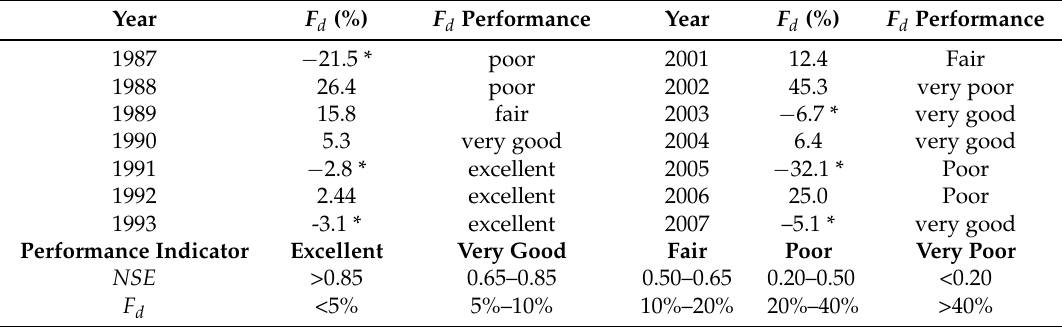
Table 3. Differences between simulated and observed annual discharges and model